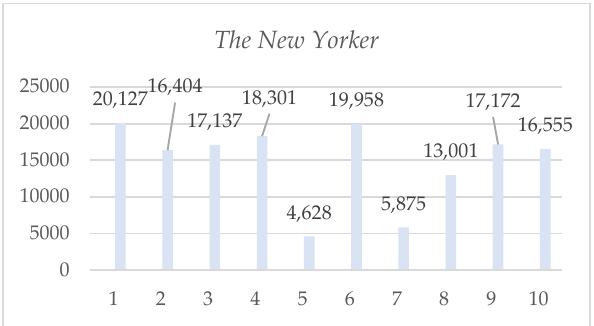
Figure 11. Length of articles on religion studied in The New Yorker .